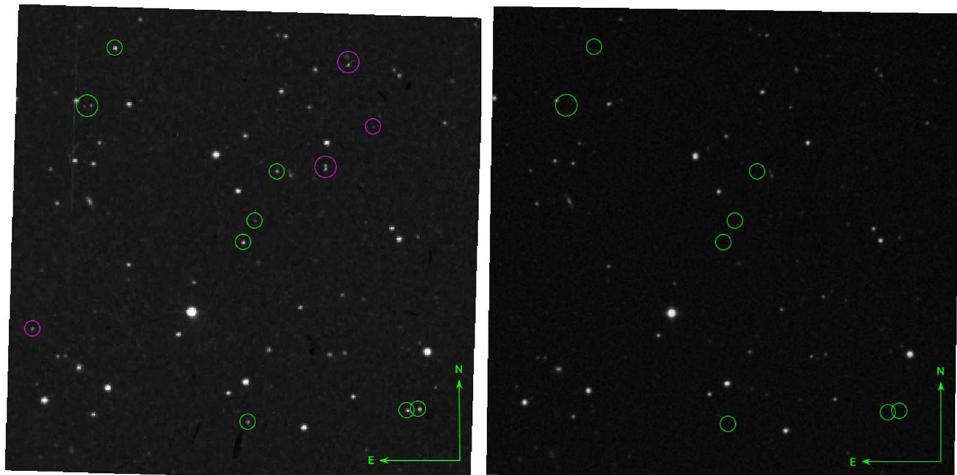
Figure 1. The same 10 x 10 arcmin field shown in POSS-1 and POSS-2 red bands. In the POSS-1 image we see a number of objects that cannot be subsequently found, marked with green circles. Purple circles are artifacts during the scanning process. About 9 objects are present in the POSS-I E image (left) from the 12th of April, but not in the POSS-2 image (right) from 1996. One slightly larger circle host two transients. In addition, the 9 objects are neither visible in the blue POSS-1 taken half an hour earlier, nor in a second POSS-1 red image taken six days later on April 18th (see additional images in Supp. Info. Fig. 2.) The 9 transients are not caused by a difference in depth or spectral sensitivity. The images are based on the DSS digitizations of the Palomar